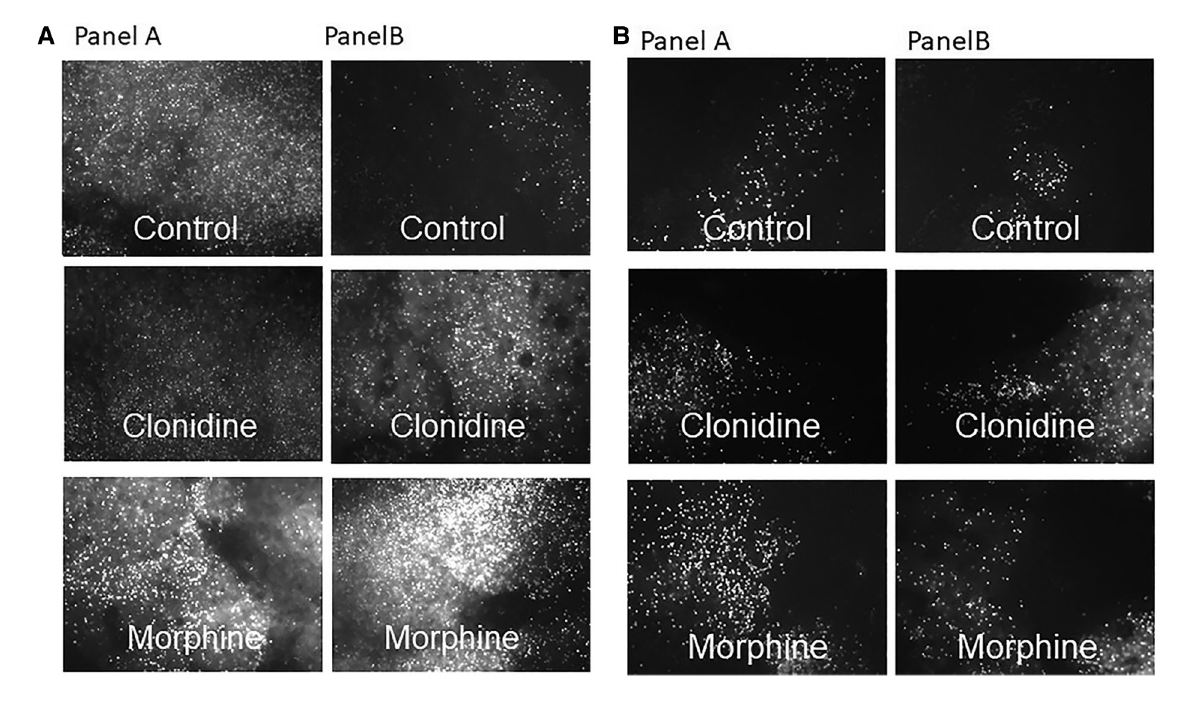
FIGURE 3 Propidium iodide staining for cell death from the PFC ( A ) and hippocampus ( B ) under fl uorescence microscopy, explants were prenatally exposed to NS (panel A) and to OXY (panel B) with postnatal treatment with control, clonidine and morphine